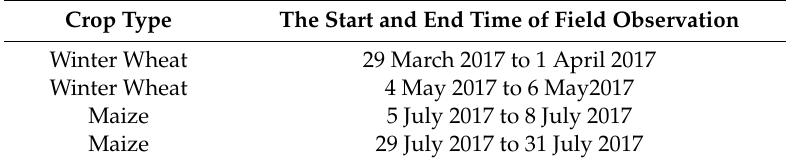
Table 1. The observation periods of the field survey fractional vegetation cover